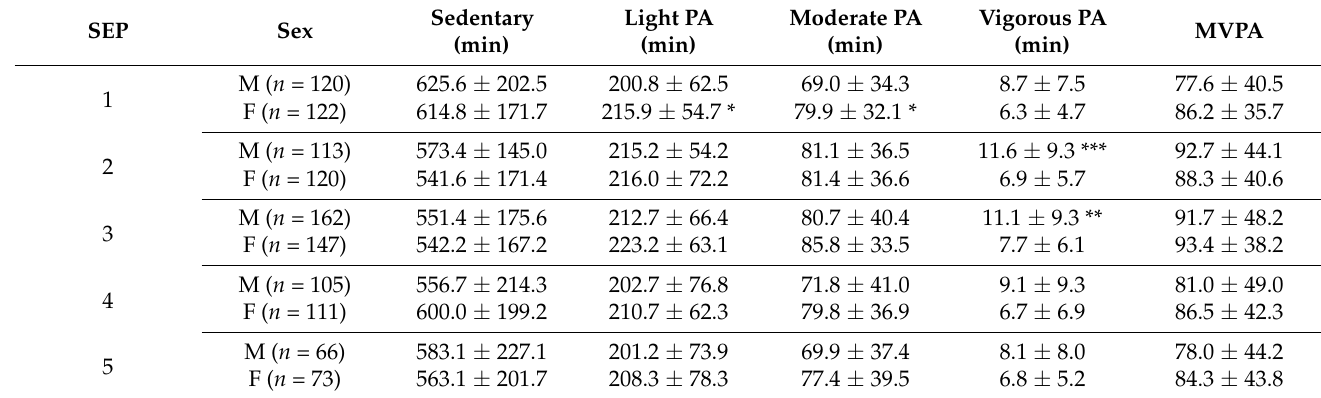
Table 4. Results of the daily sleep quality analysis in each SEP level divided by sex.